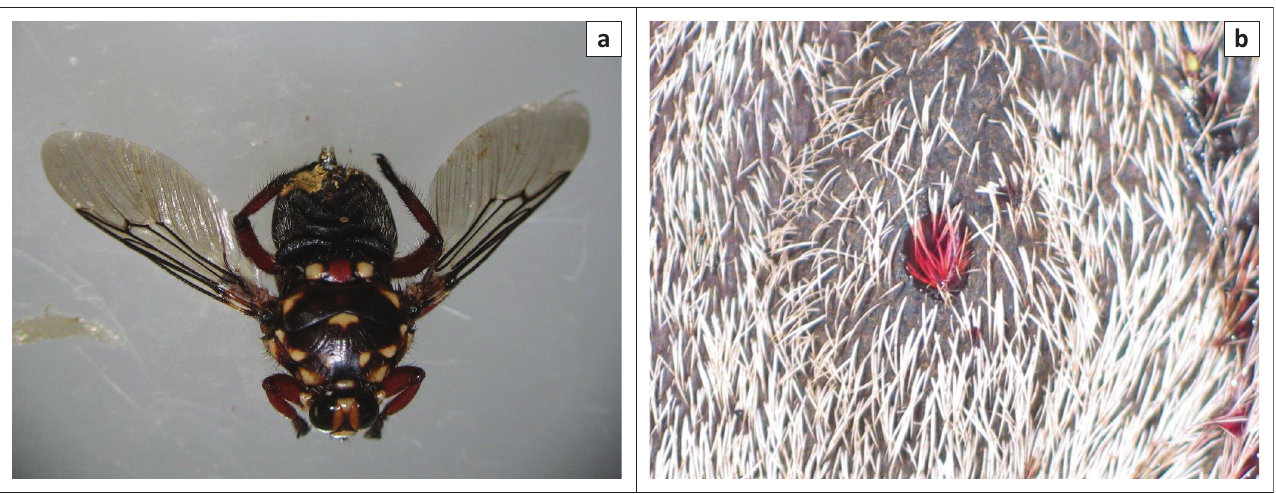
FIGURE 3: (a) Louse fly ( Hippobosca rufipes ) collected from an anthrax-positive carcass from Clearwater, South Africa, during the 2008 outbreaks. (b) Site on anthrax- positive carcass where Hippobosca rufipes had fed.